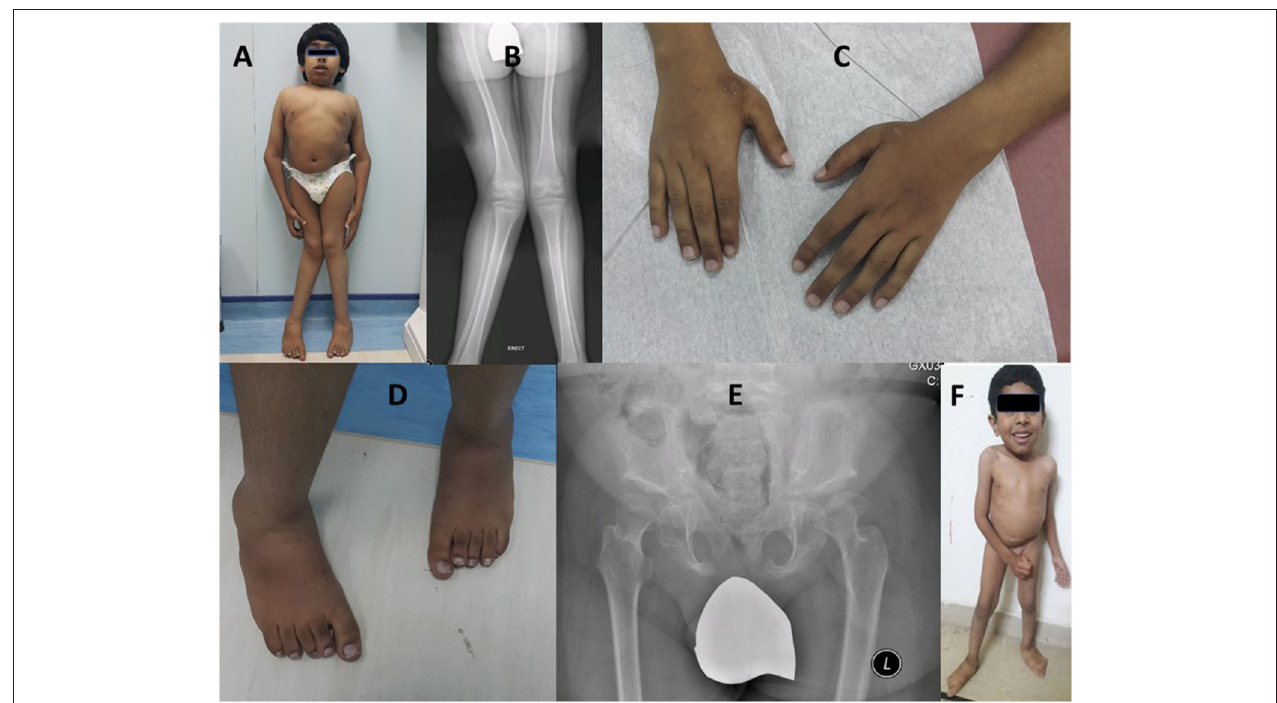
FIGURE 3 | Case-II (IV-10) presenting short trunk, genu valgum more appreciated on the right side (A,B) , brachydactyly of fingers (C) , short toes with right second toe overriding the first (C,D) . Radiological diagram of hip shows shallow acetabulum with abnormally flat and enlarged femoral head and narrow femoral neck, lace-like small iliac wings, and bilateral coxa valga (B,E) . Case-III is a 4-year-old boy (IV-13) showing short trunk, broad chest, and pes planus (F) .